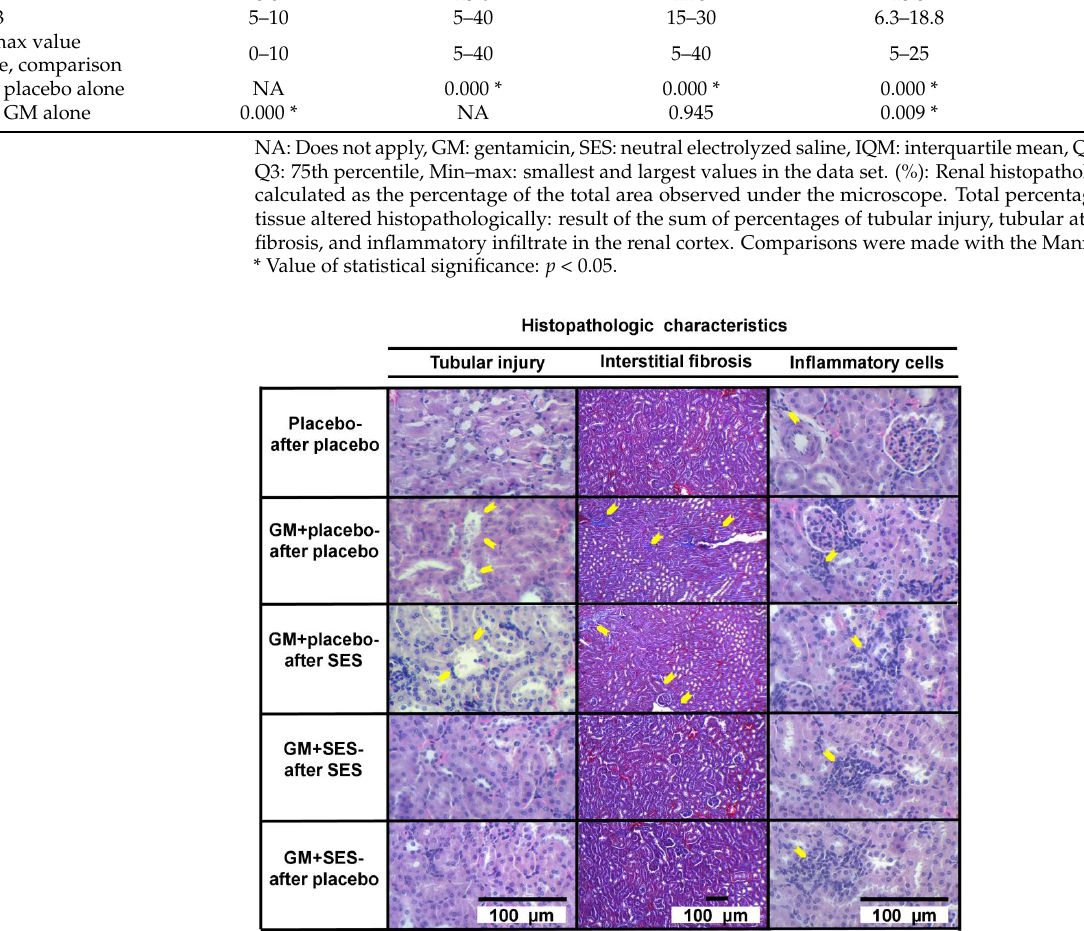
Figure 2. Effect of neutral electrolyzed saline (SES) on histopathologic changes in gentamicin (GM)- induced nephrotoxicity in the Balb/c mouse model. Placebo-after placebo group; GM + placebo-after placebo group; GM + placebo-after SES group; GM + SES-after SES group; and GM + SES-after placebo group. Yellow arrows show areas of tubular injury (flattening of the tubular epithelium, cellular fragments within their lumens, blebbing of the apical membrane into the tubular lumen, and loss of some nuclei), interstitial fibrosis, and interstitial inflammatory cell infiltration in the appropriate section. The GM + SES-after SES and GM + SES-after placebo groups showed less tubular injury and interstitial fibrosis compared with the GM + placebo-after placebo group. In addition, the GM + SES-after placebo and GM + SES-after SES groups had more interstitial inflammatory cell infiltrate than the GM + placebo-after placebo group. Tubular injury and interstitial inflammatory cell infiltrate: hematoxylin–eosin, x400; interstitial fibrosis: Masson’s trichrome, × 100; n =